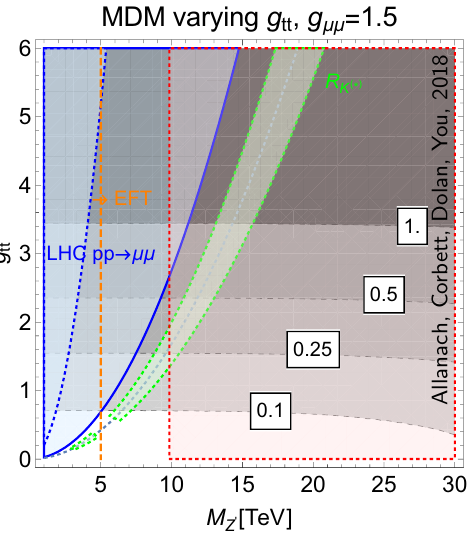
Figure 5 . 95% CL exclusion region of the ATLAS 13 TeV pp ! (cid:22)(cid:22) di-muon distribution (blue region) for 36.1 fb (cid:0) 1 (3 ab (cid:0) 1 ) denoted by dotted (solid) blue lines, as a function of M Z 0 vs g tt (cid:25) g bb for a deformed MDM model with g (cid:22)(cid:22) = 1 : 5. g bs is (cid:12)xed to its anomaly compatible value. The region of EFT validity for this analysis lies to the right of the vertical orange dotted line. Contours of (cid:0) Z 0 =M Z 0 are represented by dashed grey lines. The anomaly-compatible region within 1 (cid:27) is shown in green, while the B s (cid:0) B S mixing constraint is in